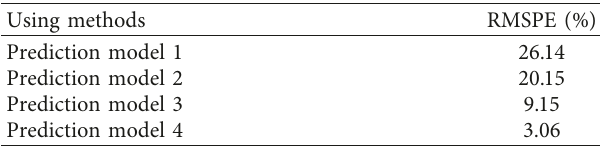
Table 4: Prediction model root mean square error. Using